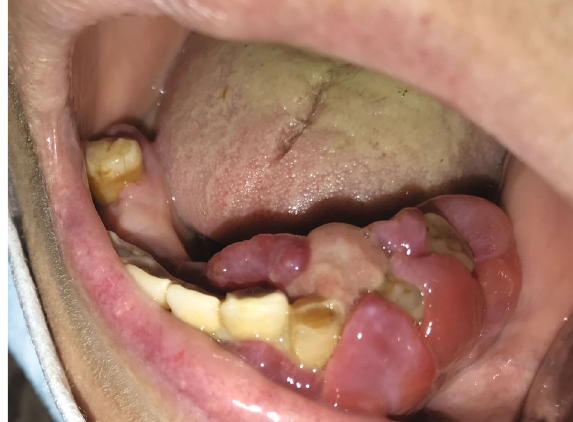
Figure 2: Yellowish-white pseudomembranous slough was found covering the interdental papilla in the mandibular left area.